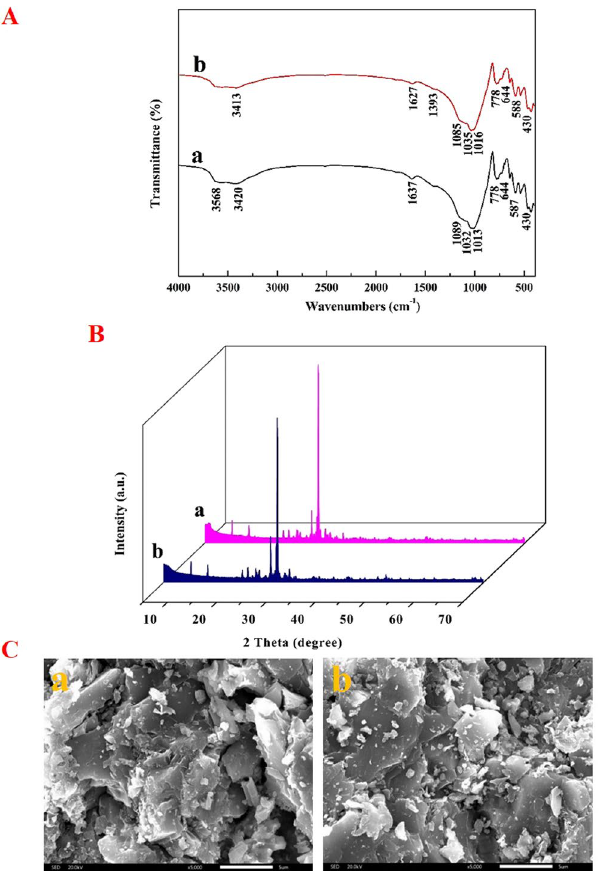
Figure 7. ( A ) FTIR spectra of (a) RMF and (b) CMMF-H2.5-400 after adsorption. ( B ) XRD patterns of (a) RMF and (b) CMMF-H2.5-400 after adsorption. ( C ) SEM micrographs of (a) RMF and (b) CMMF-H2.5-400 after